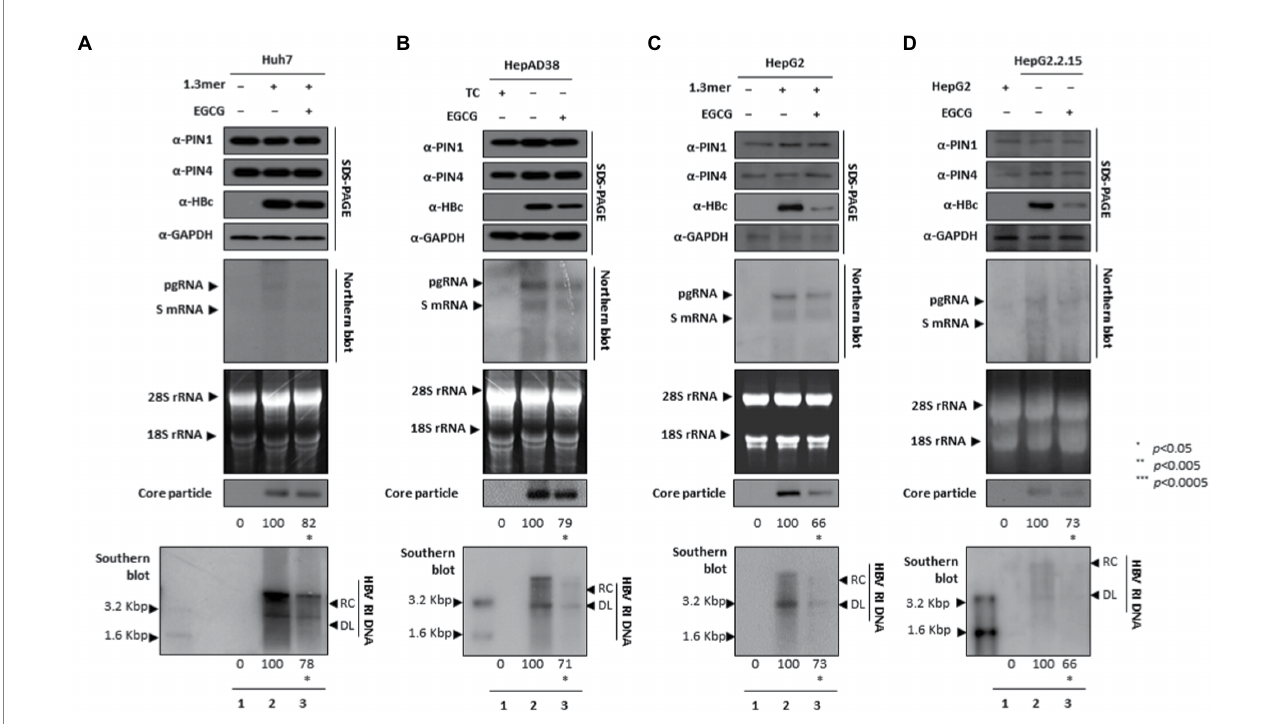
FIGURE 8 PIN1 and PIN4 inhibition via EGCG reduced HBV replication in Huh7, HepAD38, HepG2, and HepG2.2.15. (A–D) EGCG reduced HBV replication. (A) The Huh7 cells were mock-transfected (lane 1), transfected with 4 μ g of 1.3 mer HBV WT and treated with nuclease-free water solvent (lane 2), or transfected by 1.3 mer HBV WT (4 μ g) and treated with 40 μ M of EGCG for 72 h (lane 3). (B) HepAD38 was treated with mock (none, lane 1) or solvent (lane 2), or treated with 40 μ M EGCG (lane 3) for 72 h. (C) HepG2 cells were transfected with mock (lane 1), 1.3 mer HBV WT (4 μ g) transfected and treated with solvent (lane 2), or 4 μ g 1.3 mer HBV WT transfected and treated with EGCG (40 μ M) for 72 h (lane 3). (D) HepG2.2.15 cells were treated with solvent (lane 2) or EGCG (40 μ M) treated for 72 h (lane 3). Lane 1 indicates mock-transfected HepG2 cells (negative control). The cellular lysates were subjected to SDS-PAGE and immunoblotting, NAGE, Northern, and Southern blotting. The presented data are representative of three independent experiments. The statistical analysis was determined using Student’s t -test. * p < 0.05, ** p < 0.005, *** p < 0.0005 relative to the